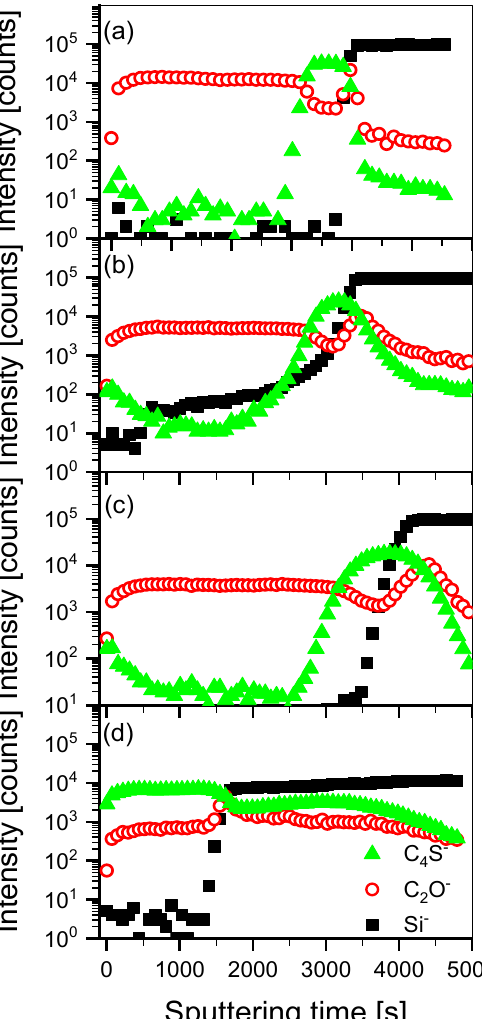
Figure 2. SIMS depth profiles of PC 60 BM/P3HT bilayers: ( a ) as-prepared or exposed for 1 h to vapors of ( b ) THF, ( c ) DCE, and ( d ) chloroform. of ( b ) THF, ( c ) DCE, and ( d )